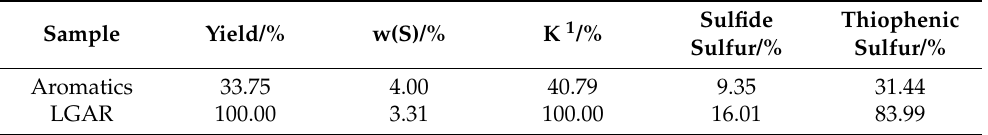
Table 1. The yield and sulfur distribution in LGAR